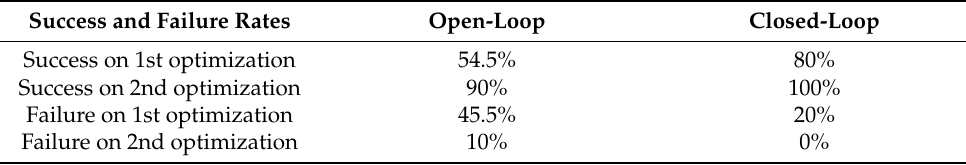
Table 1. Success and failure rates for the open-loop and closed-loop validation sets. Success and Failure